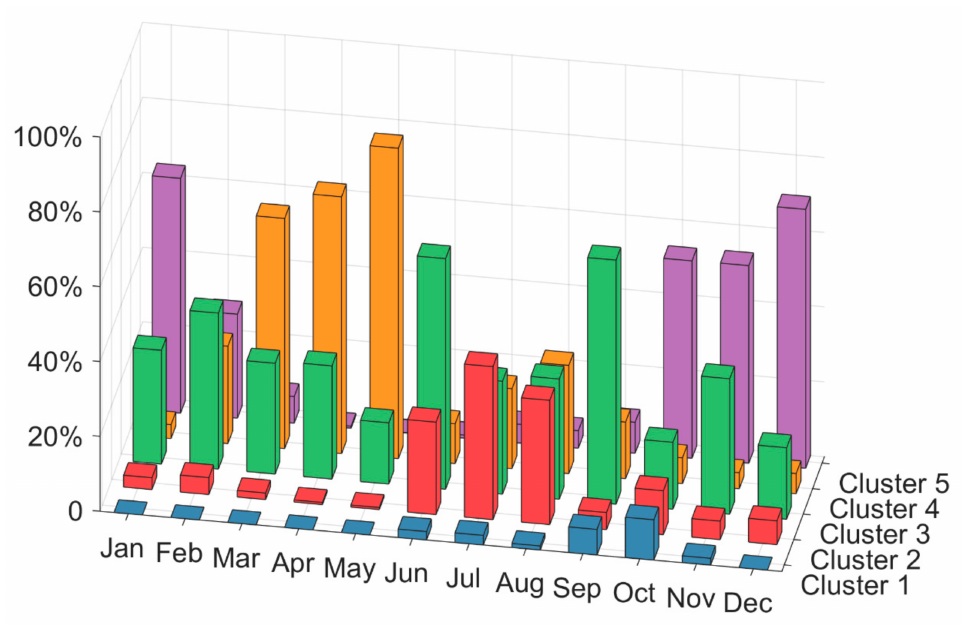
Figure 6. Frequency distribution of the meteo-climatic clusters according to month (June 2020 to September